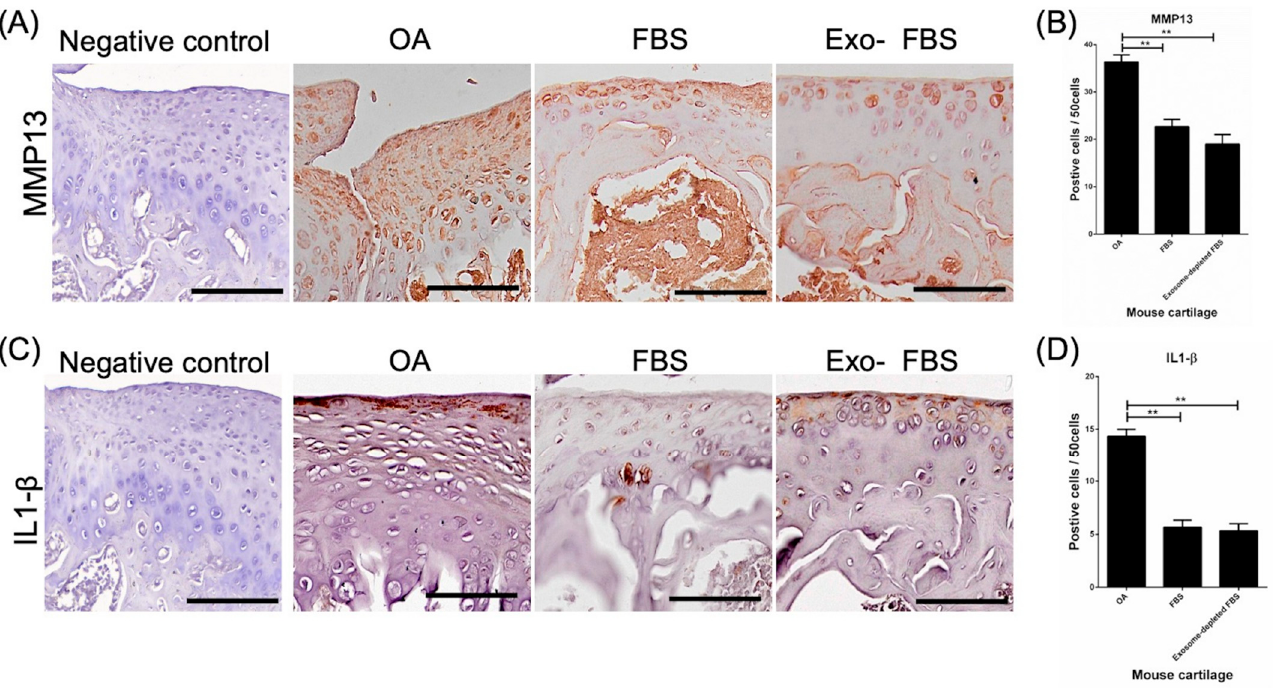
Figure 7. Immunohistochemistry (IHC) of MMP13 and IL ‐ 1 β in destructed cartilages of mice. ( A ) After 28 days of experiments, a representative image of MMP13 in the normal cartilage (IHC negative control), normal saline control, and exosome +/ − FBS ‐ cultured HUCMSC ‐ treated knees ( n = 3). Scale bar = 100 μ m. ( B ) Quantification of MMP13 in the three groups. ** p < 0.01. ( C ) Representative image of IL ‐ 1 β in the normal cartilage (IHC negative control), normal saline control, and exosome +/ − FBS ‐ cultured HUCMSC ‐ treated knees ( n = 3). Scale bar = 100 μ m. ( D ) Quantification of IL ‐ 1 β expression in the three groups. ** p < 0.01. Representative results from 3 experiments. HUCMSCs were derived from the same donor.